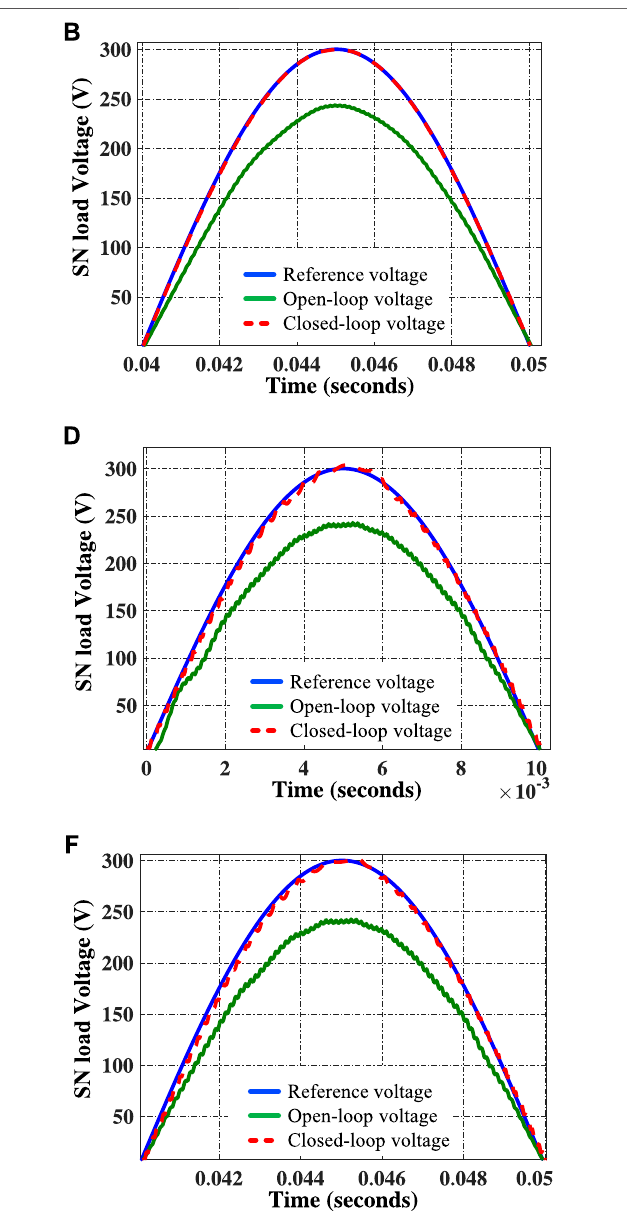
Frontiers in Energy Research |